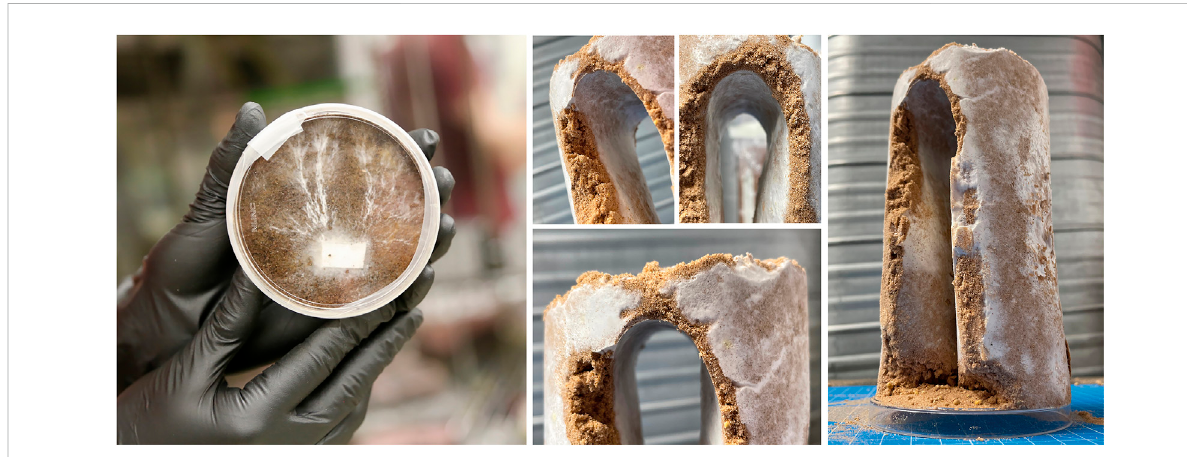
FIGURE 8 Mycelia growing on Martian regolith simulant, sand